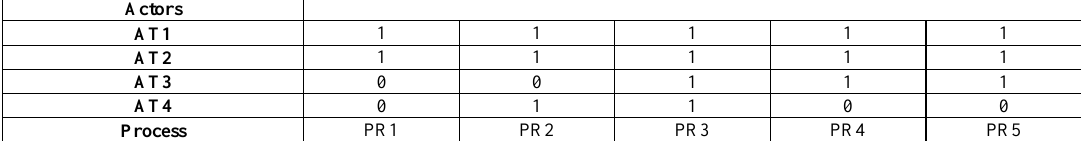
Table 10. Cross interaction binary matrix for actors and process in binary form.